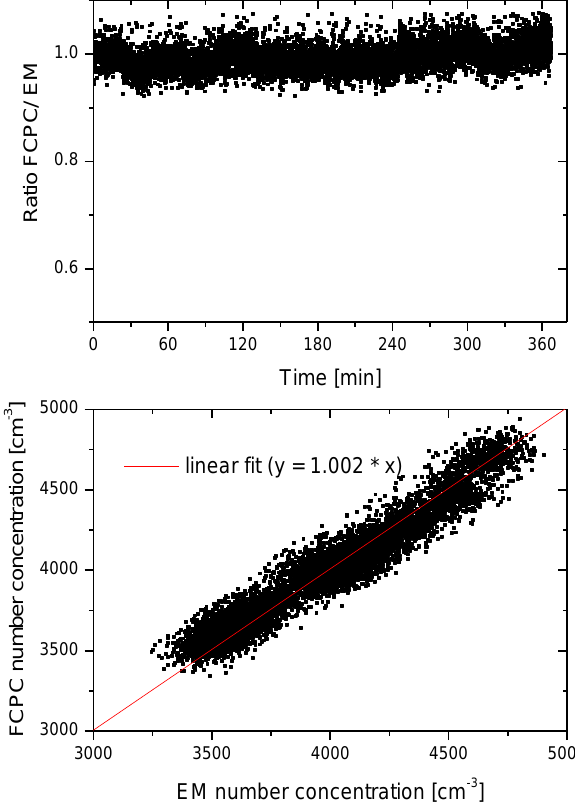
Fig. 7. Counting efficiency of the FCPC in comparison with the electrometer (ratio FCPC/EM) measuring 30-nm silver particles at 37 ◦ C | 10 ◦ C: the upper plot shows the ratio FCPC/EM, the lower one the corresponding scatter plot of the number concentrations. The red line displays the linear trend in the lower plot.